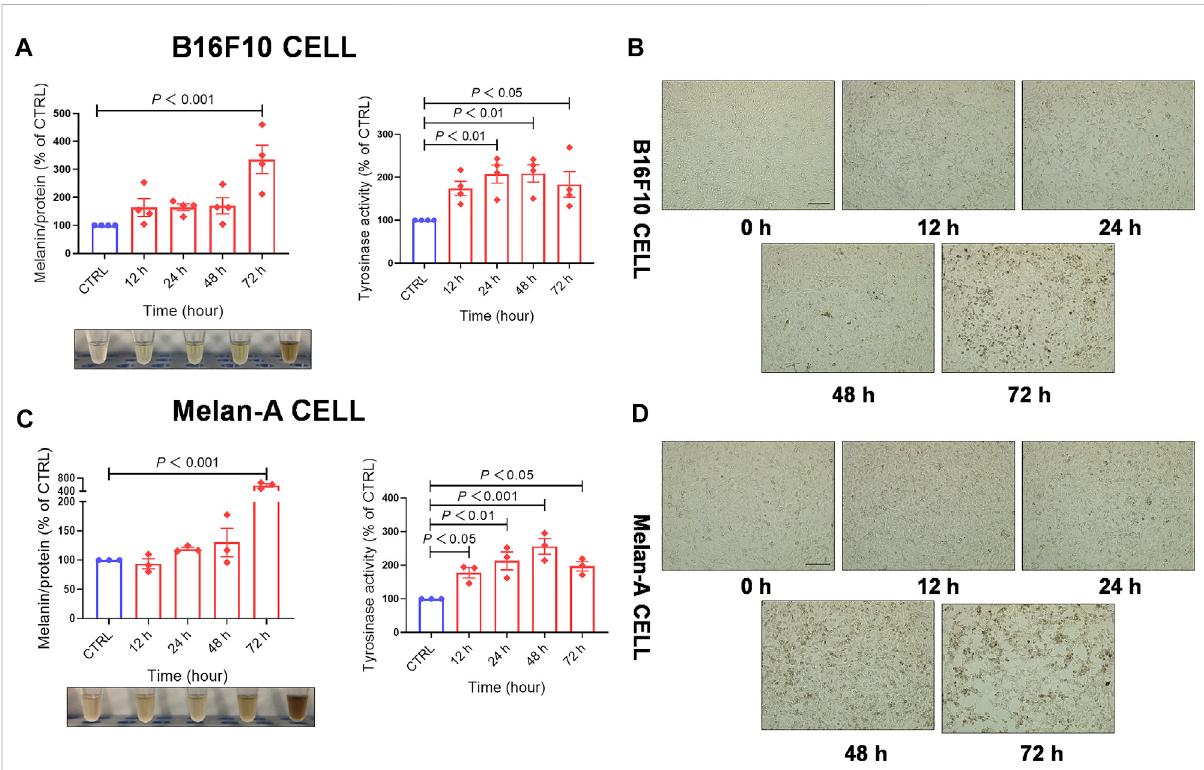
FIGURE 2 EFE increases melanin production and promotes tyrosinase activity in a concentration- and time-dependent manner. (A) Melanin content, melanincolor,andtyrosinaseactivityonB16F10cellsbasedondifferenttimesof12 h,24 h,48 h,and72 hfor40 μ g/ml; (B)